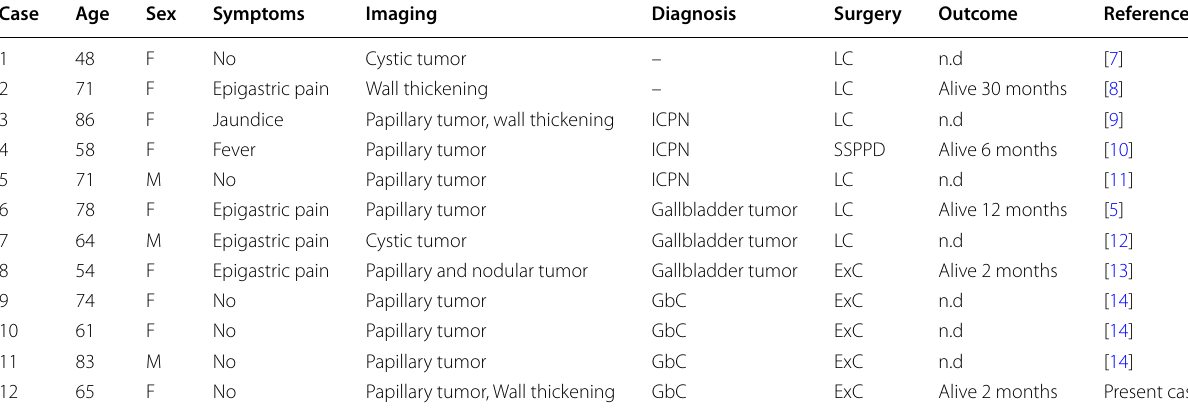
ExC extended cholecystectomy, F female, GbC gallbladder cancer, ICPN intracystic papillary neoplasm, LC laparoscopic cholecystectomy, M male, n.d no data, SSPPD subtotal stomach preserving